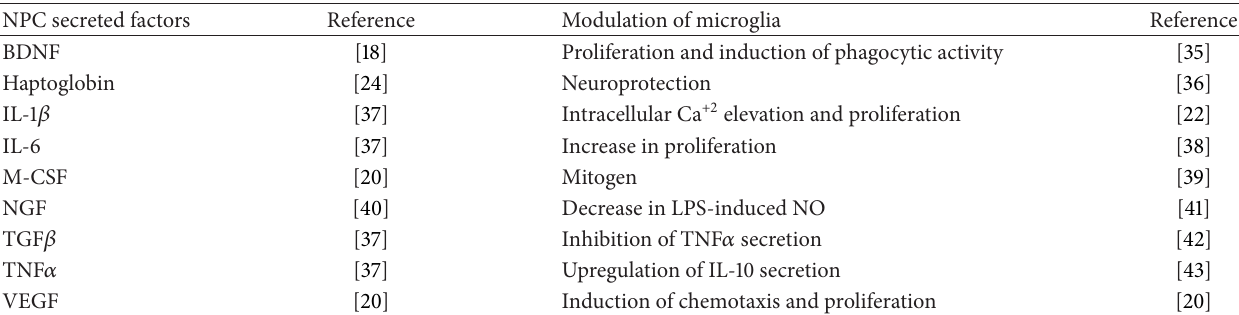
Table 2: Summary of factors secreted by neuroprogenitors and the potential effect they have on microglia in vitro